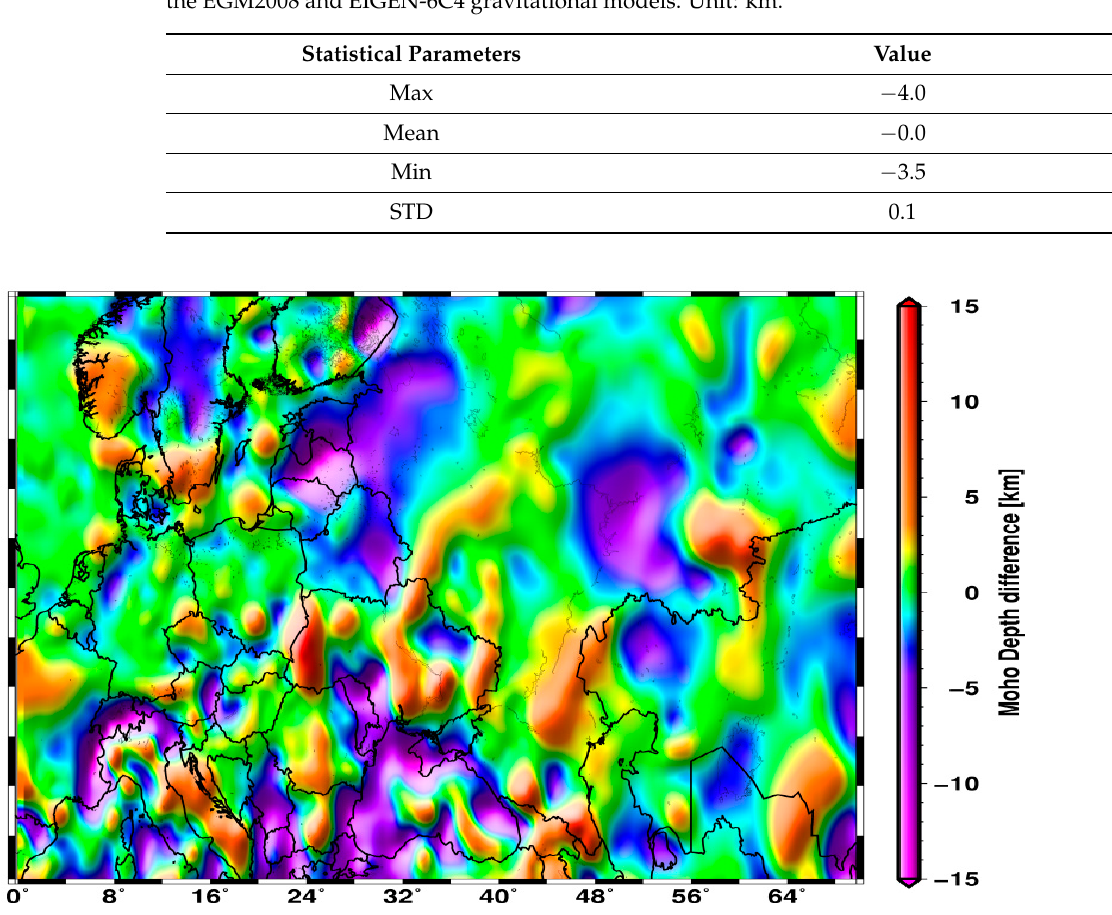
Figure A2. The Moho depth differences between the Eurasian [5] and European [29] models within Europe. Unit: